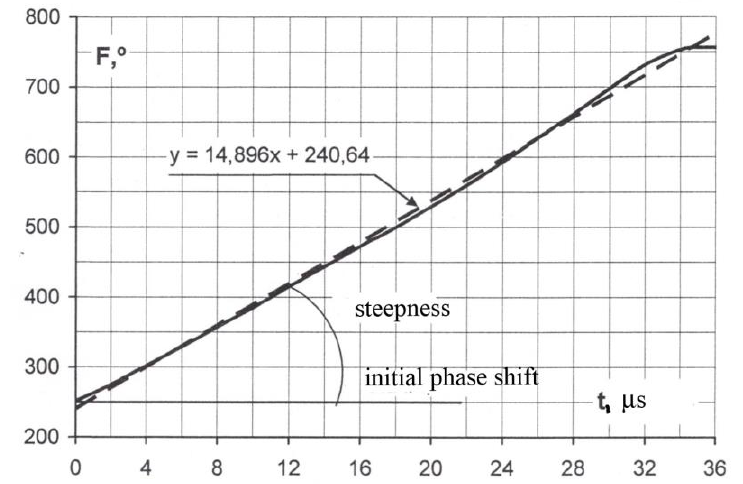
Fig. 4. Linearized phase-time characteristic of Faraday type